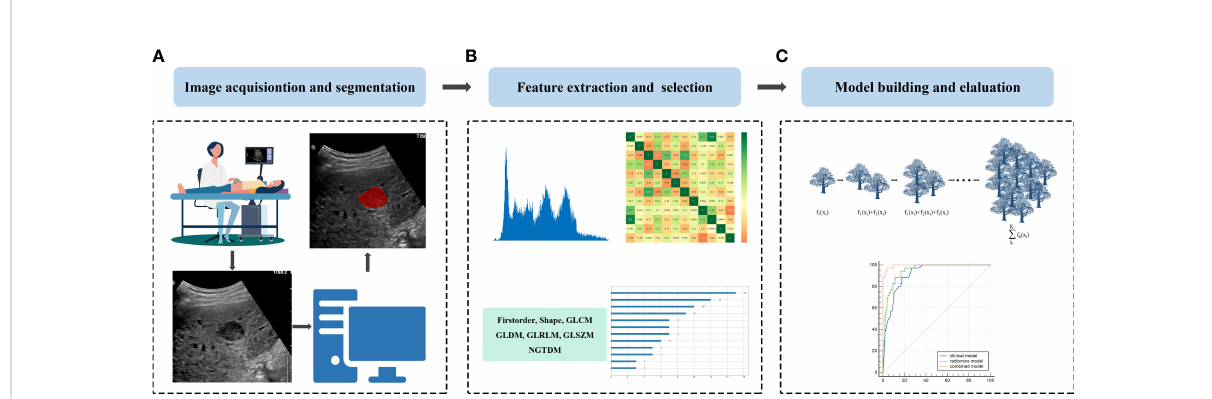
FIGURE 2 Schematic diagram of the overall study: (A) Image acquisition and lesion segmentation; (B) Feature extraction and feature selection, and (C) Model construction and evaluation.